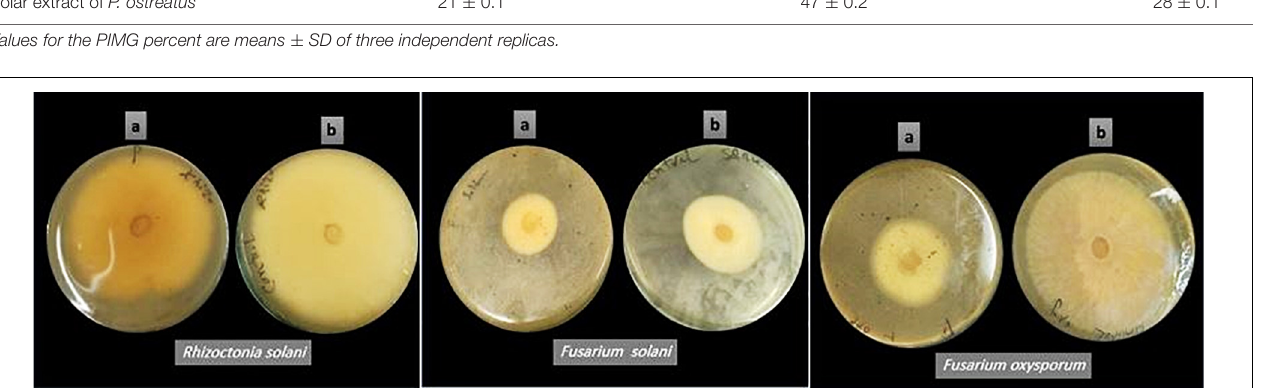
Percent of inhibition of mycelial growth (PIMG) %